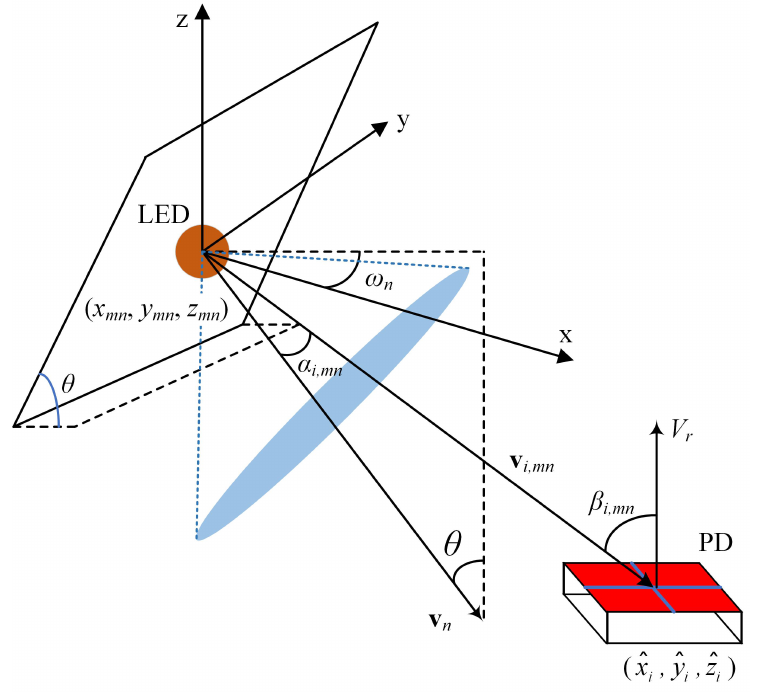
Figure 4. Geometry for LOS channel gain calculation of the side LEDs in the